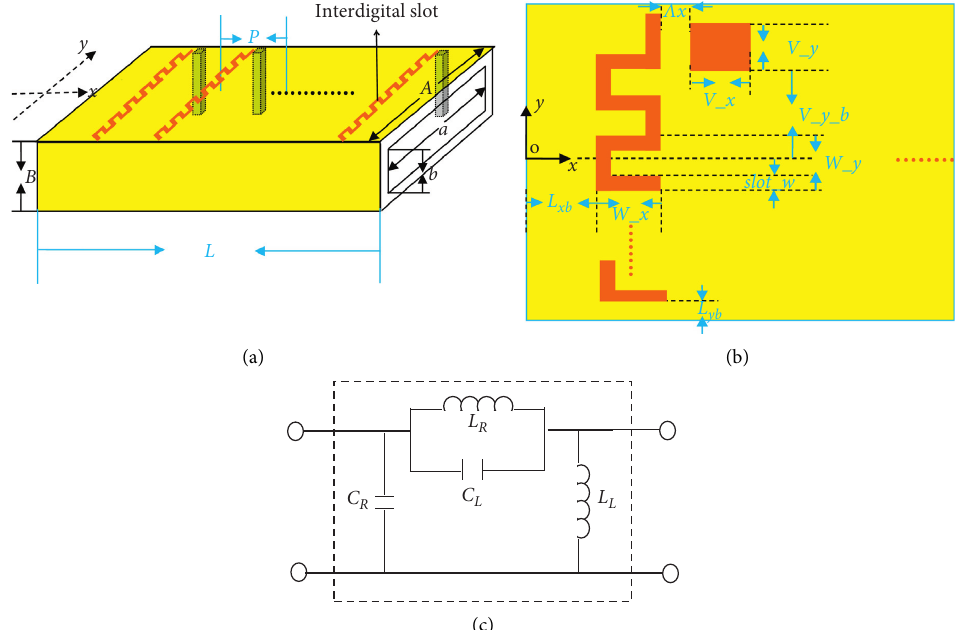
Figure 2: The proposed periodic leaky rectangular waveguide: (a) perspective view of the whole structure; (b) structure and parameters of the unit cell; (c) equivalent circuit of the unit cell.